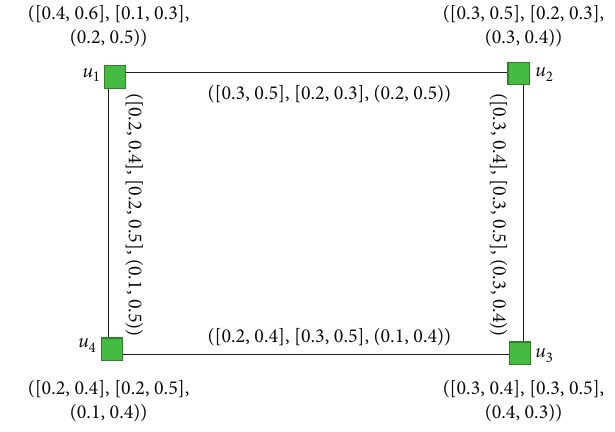
Figure 6: Cubic strong intuitionistic fuzzy graph.